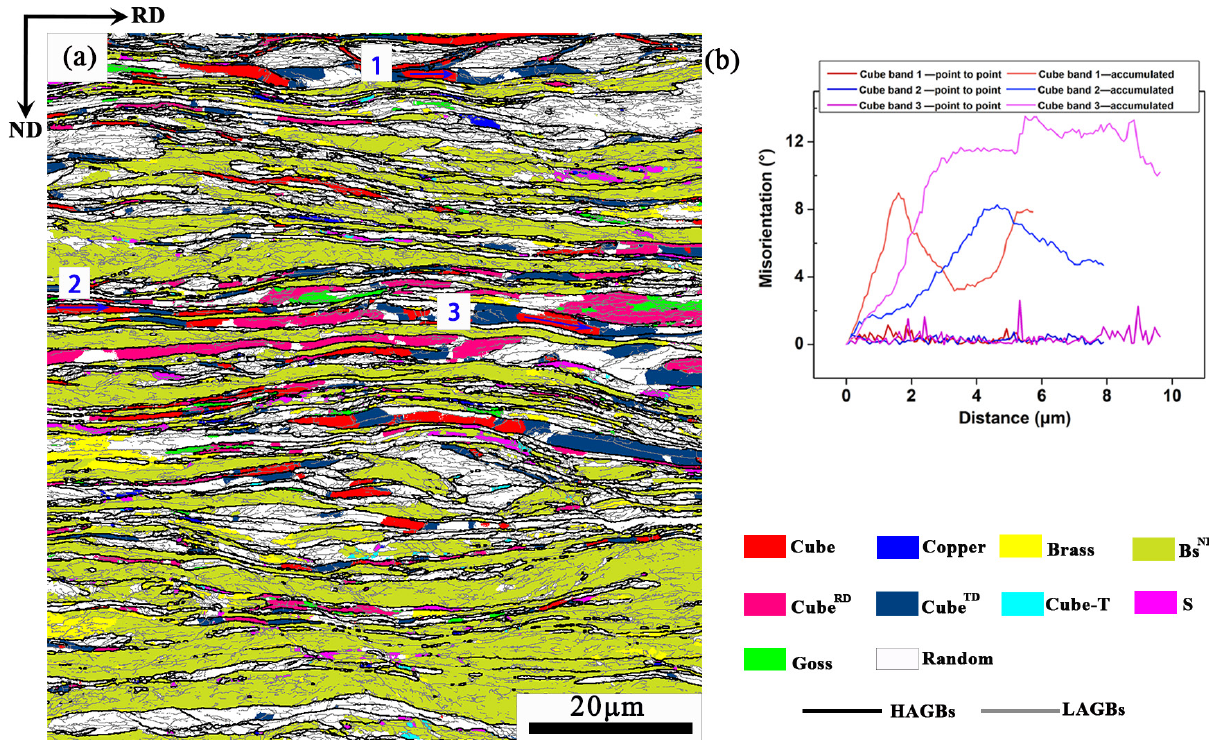
Figure 3: (a) EBSD orientation map displaying deformation microstructure for deformed nickel and (b) the point-to-point and accumulated misorientation in cube-oriented deformation bands.